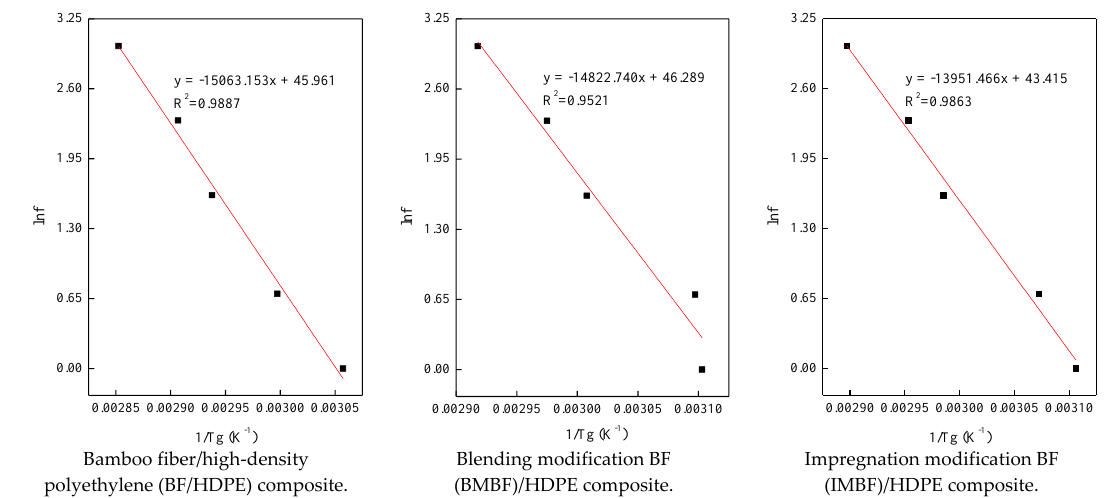
Figure 5. Ea values of composites. Figure 5. E a values of